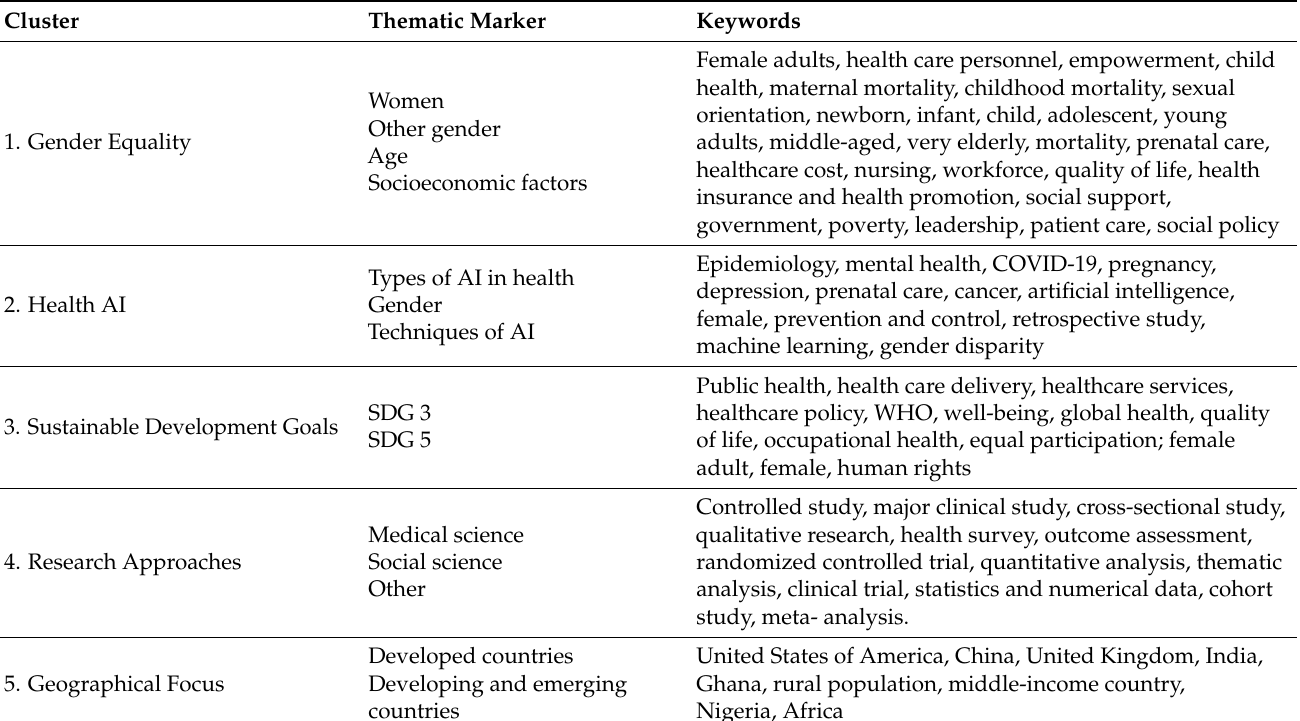
Table 1. System of Article Categorization: Gender Equality in Health AI.